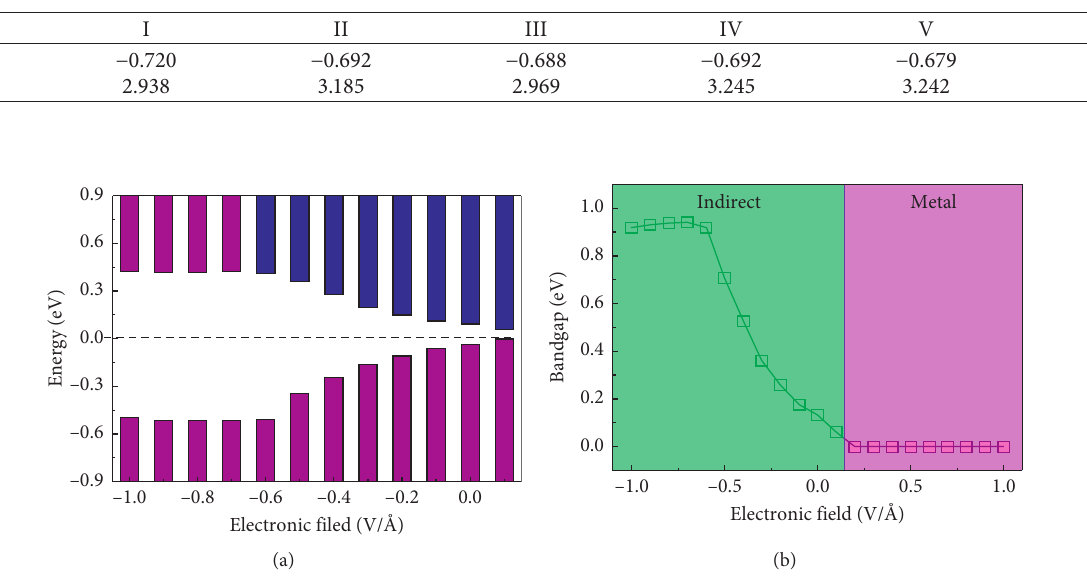
Figure 3: Graphs showing (a) the band edge and (b) the bandgap as a function of the external electric field strength that is applied to the silicane/SnSe 2 vdW